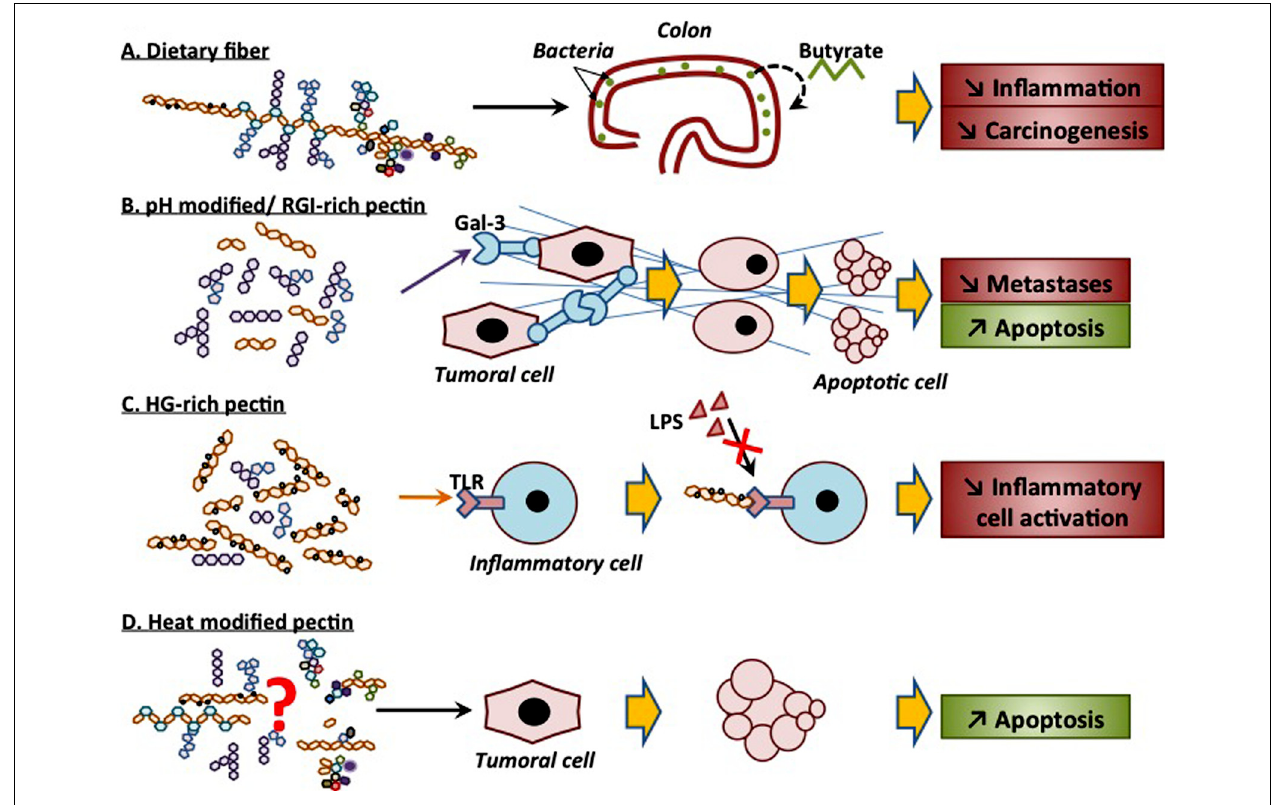
FIGURE 2 | Schematic representation of the different anti-cancer activities of different forms of pectin